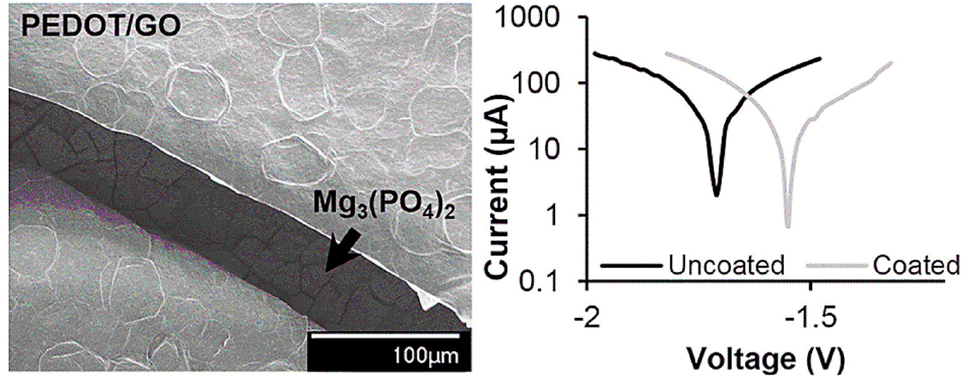
Figure 6. Morphology and Tafel plots of poly(3,4-ethylenedioxythiphene)/graphene oxide (PEDOT/GO) nanocomposite for coated and noncoated samples [100]. Reproduced with permission from Elsevier.